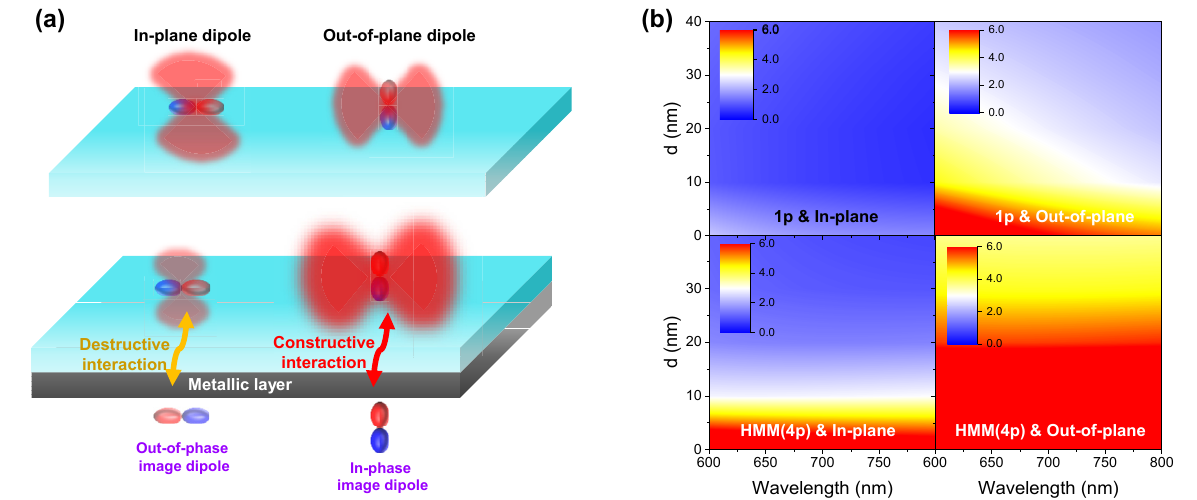
Figure 1: Schematic description of image dipole interaction and calculation of Purcell factor depending on the dipole orientations. (a) Schematics of in-plane and out-of-plane transition dipoles without (top) and with (bottom) HMM substrate, in which in-plane (out-of-plane) dipole moment decreases (increases) due to destructive (constructive) interaction with its image dipole. (b) Numerical simulations of Purcell factor for in-plane and out-of-plane dipoles, as functions of d and wavelength in the presence of 1p and HMM (4p) for the